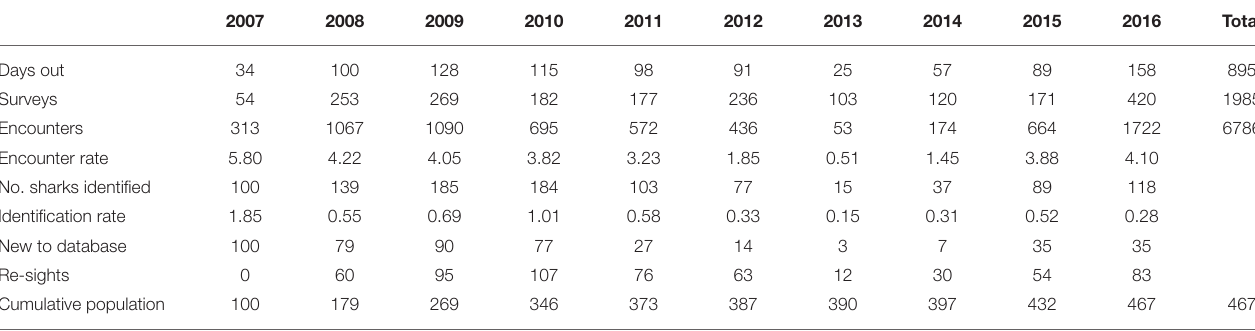
TABLE 1 | Survey effort, encounter and identification rates of whale sharks in Donsol from 2007 to